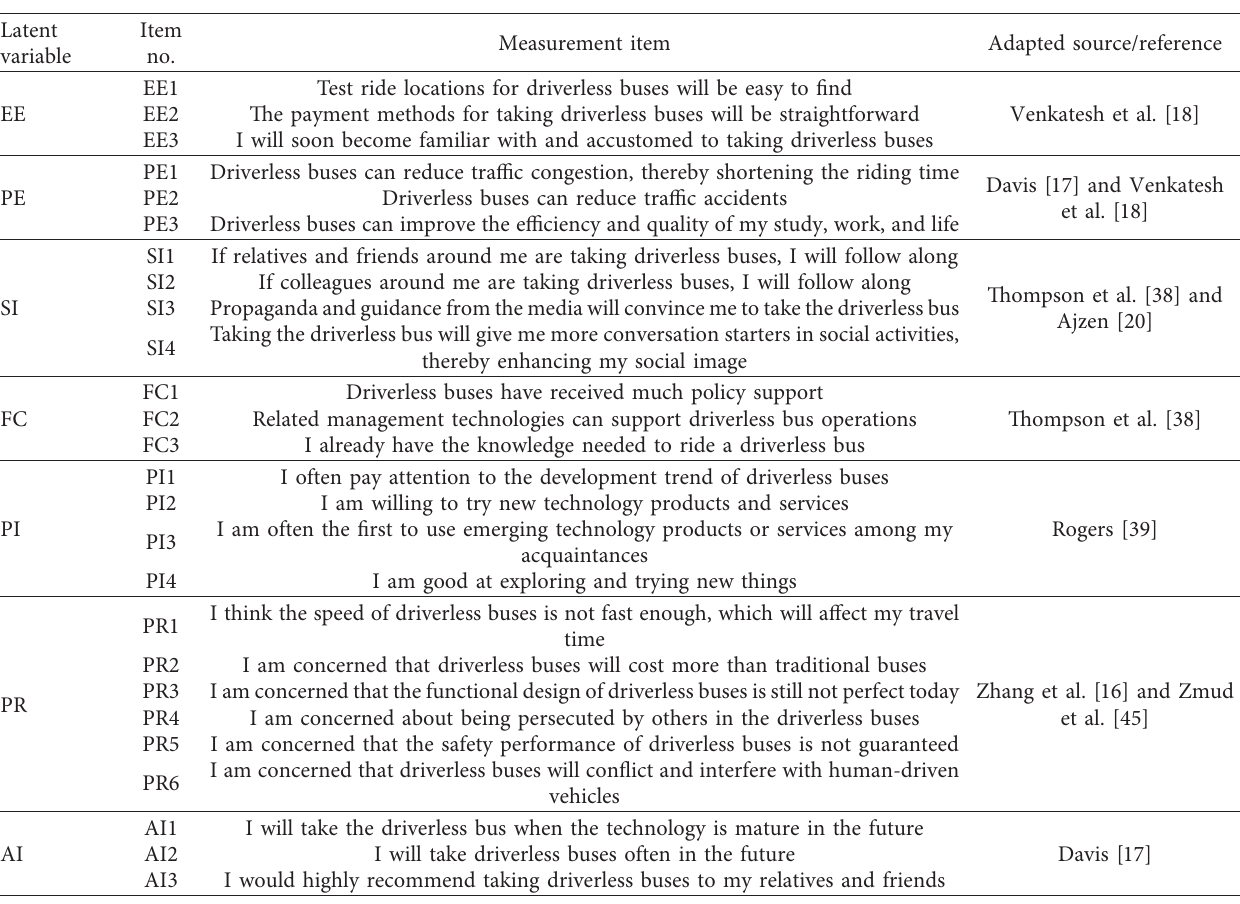
Table 3: Measurement items for model